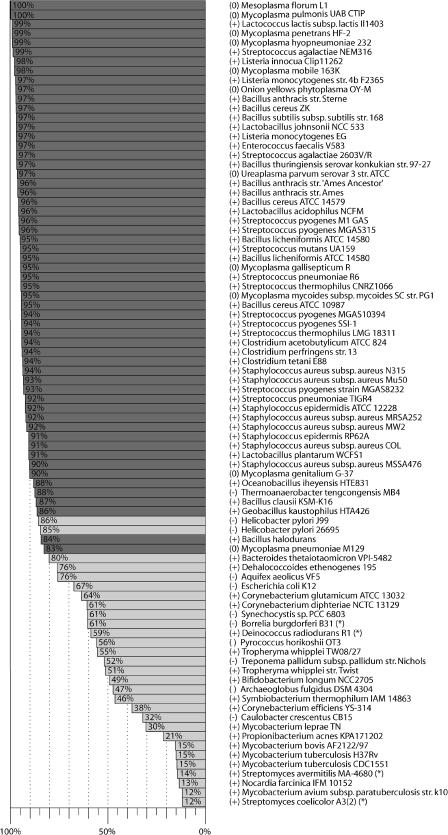
Sensitivity of Predicting Transcriptional Terminators, Evaluated for 57 Firmicutes and 29 Other Bacterial Species
Firmicutes are shown in dark gray; other bacterial species are shown in light gray. (+), (−), or (0) in front of the organism name denotes that the organism is Gram-positive, Gram-negative, or lacks a cell wall, respectively.